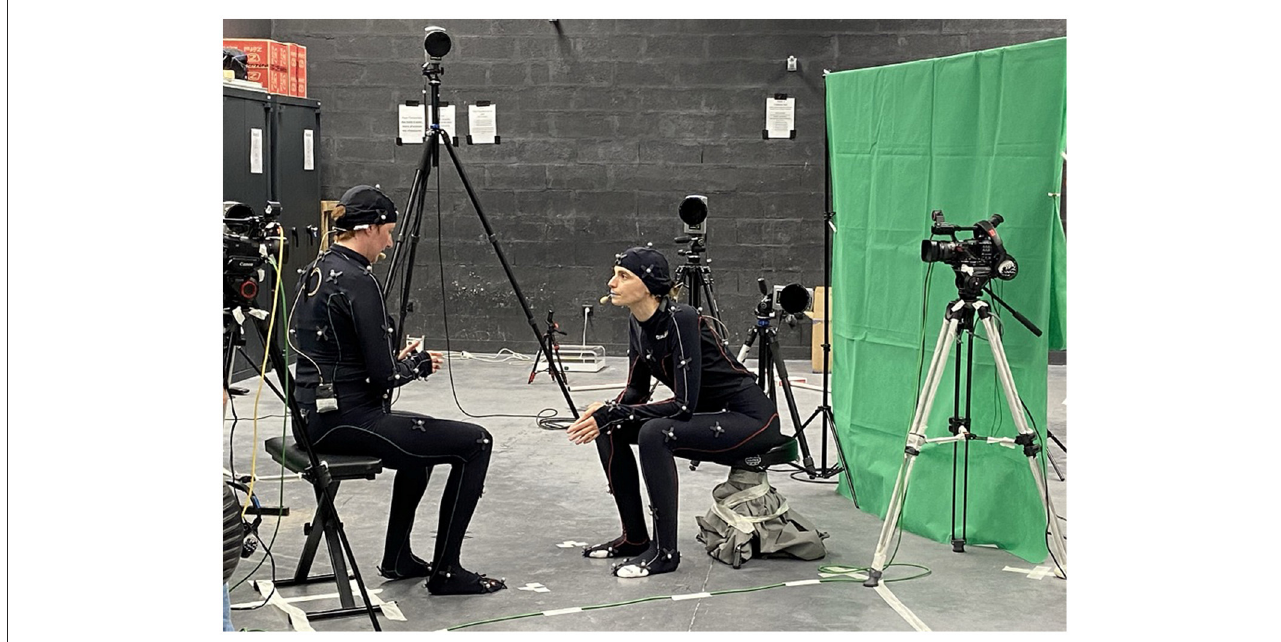
FIGURE2 Recording room.